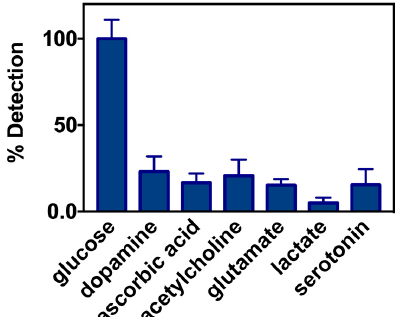
Figure 2. The resulting cathodic current recorded at − 0.5 V and illustrating selectivity by the glucose oxidase and gold nanoparticle modified carbon fiber microelectrode (GOx–AuNP–CFME) ( n =